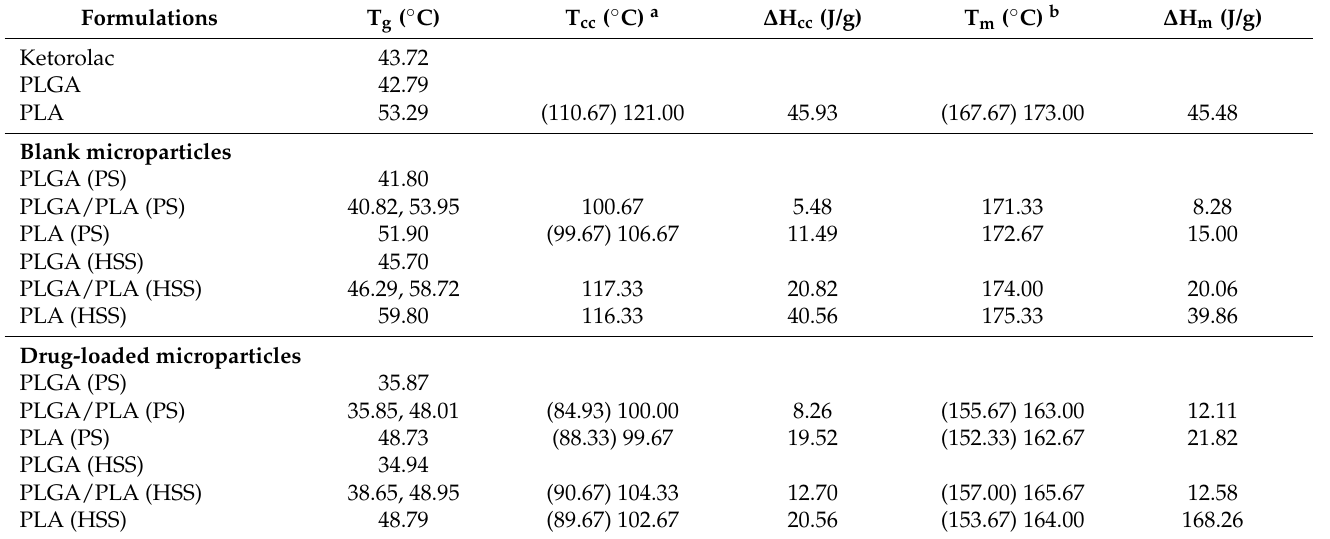
Table 2. Temperatures of glass transition (T g ), cold crystallization (T cc ), and melting (T m ) and enthalpies of cold crystallization ( ∆ H cc ) and melting ( ∆ H m ) of individual components, blank and drug-loaded microparticles recorded from the second